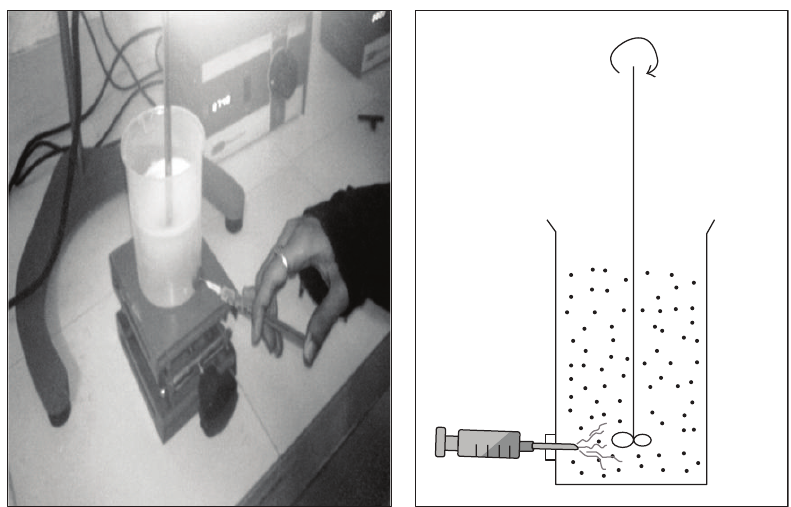
Figure 1: Method of injection of volatile phase into liquid